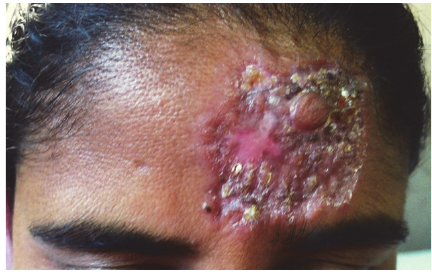
Figure 1: Plaque with warty surface on